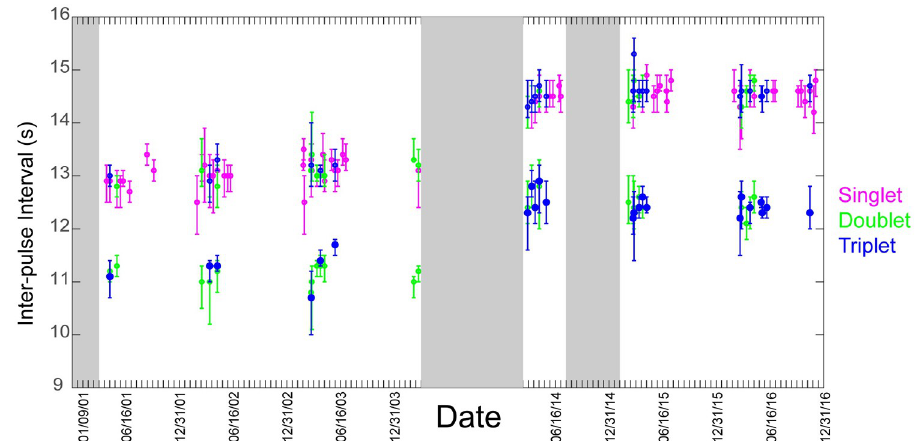
Fig 3. Daily median fin whale song inter-pulse interval (IPI). Plot of daily median song IPI, with error bars representing first & third quartiles. Each datapoint summarizes the song from a randomly selected date from each half- month. Singlets are in pink, doublet variants in green, and triplets in blue. Gray-shaded areas indicate breaks in recording effort. Dates on the x-axis are reported in mm/dd/yy format.